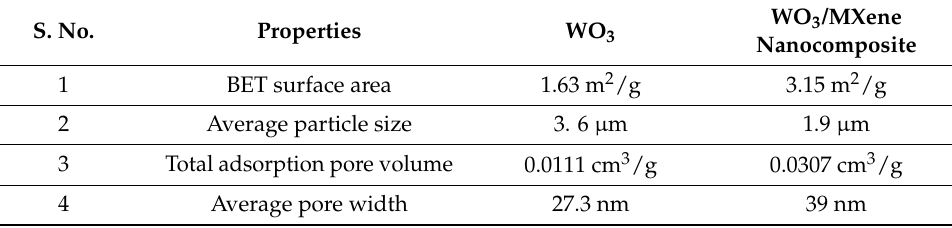
Figure 7. Nitrogen adsorption – desorption isotherm of ( a ) WO 3 and ( b ) WO 3 /MXene nanocomposite. Table 1. Surface properties of WO 3 , WO 3 /MXene nanocomposite calculated from BET analysis. S.